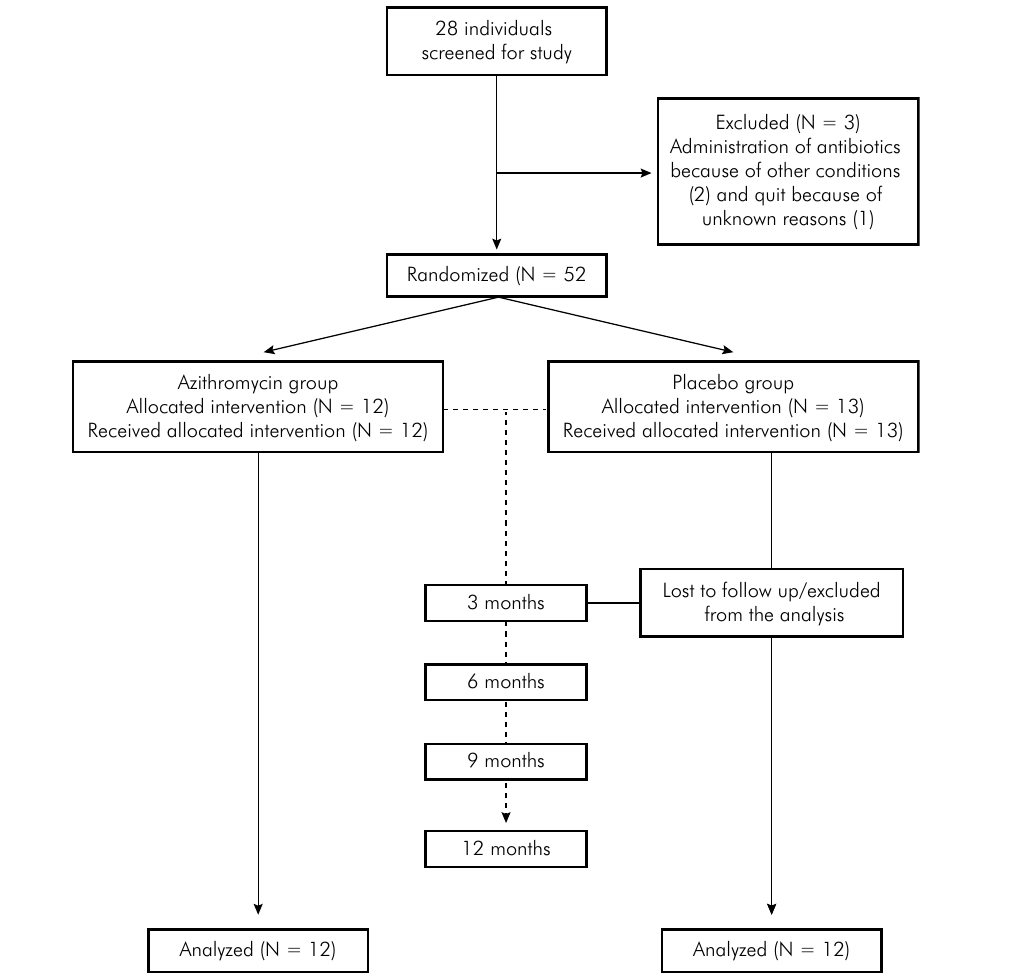
Figure 1. Flowchart of participation in the study